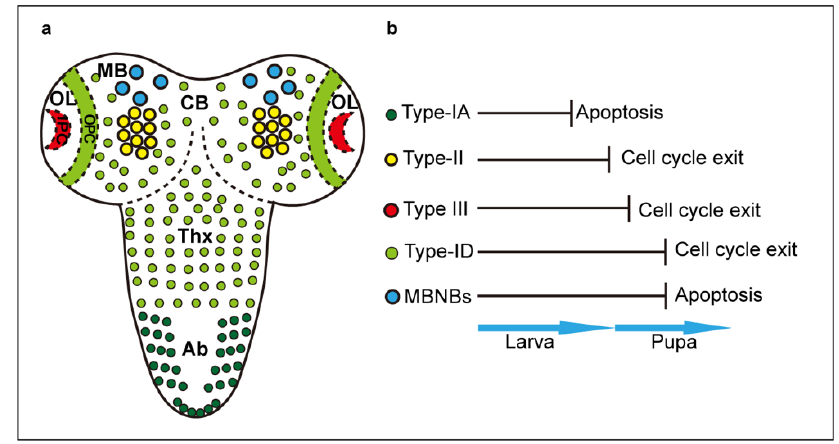
Figure 1. Neuroblasts in the larval CNS. ( a ) Distinct types and d istribution of developmental NB. ( b ) NB termination via cell cycle exit or apoptosis. CB: central brain; MB: mushroom bodies; OL: optic lobes; OPC: outer proliferation centre; IPC: inner proliferation centre; Thx: VNC thorax; Ab: VNC abdomen.